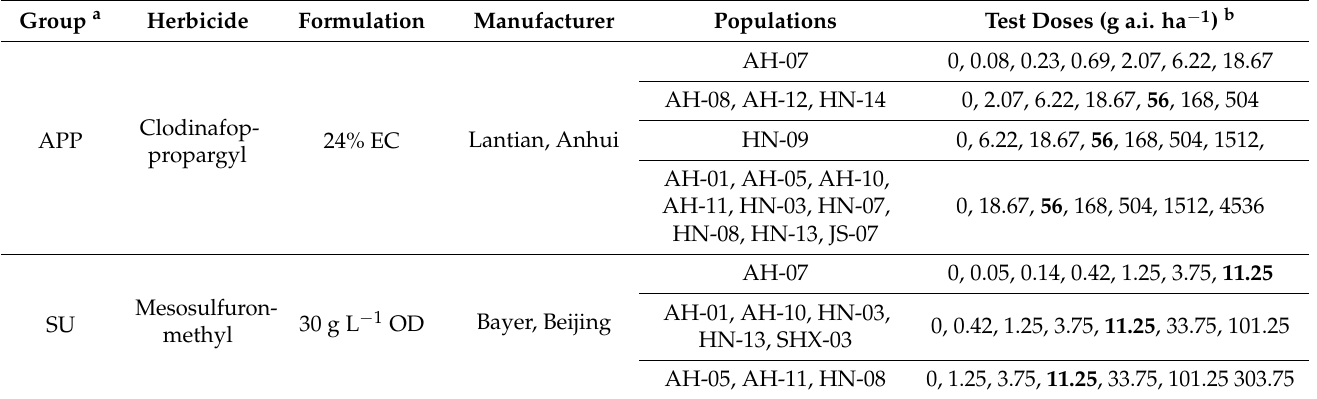
Table 2. Herbicides and their doses used in the whole-plant dose-response experiments for different L. multiflorum